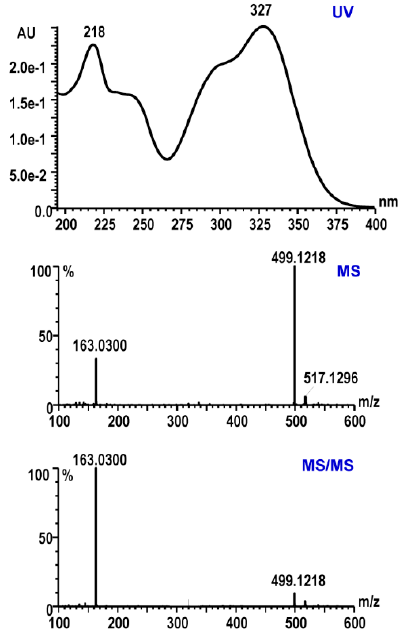
Figure 1. UV, MS, and MS/MS spectra of 3,5-dicaffeoylquinic acid.